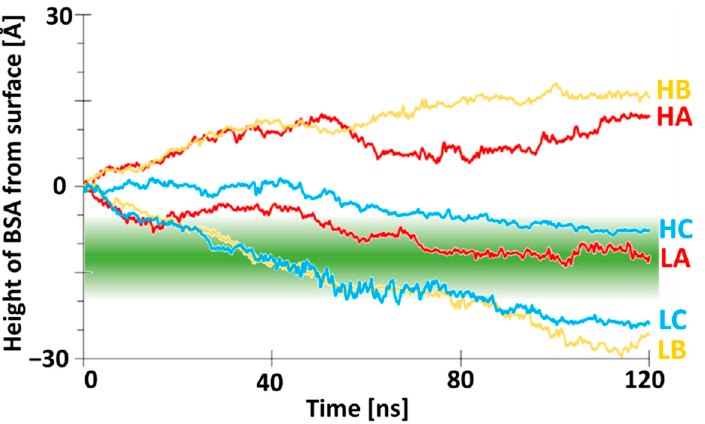
Figure 4. The height of the BSA from the surfaces for each model (see Figure 3 for details about the different models) along the MD simulations. The height distance values of the BSA from the surface were measured along the Z-component axis for the C α atoms of amino acids. The values presented in the graph are taken from the lowest C α atom of the protein. The green band represent the averaged positions of the polymer chains.